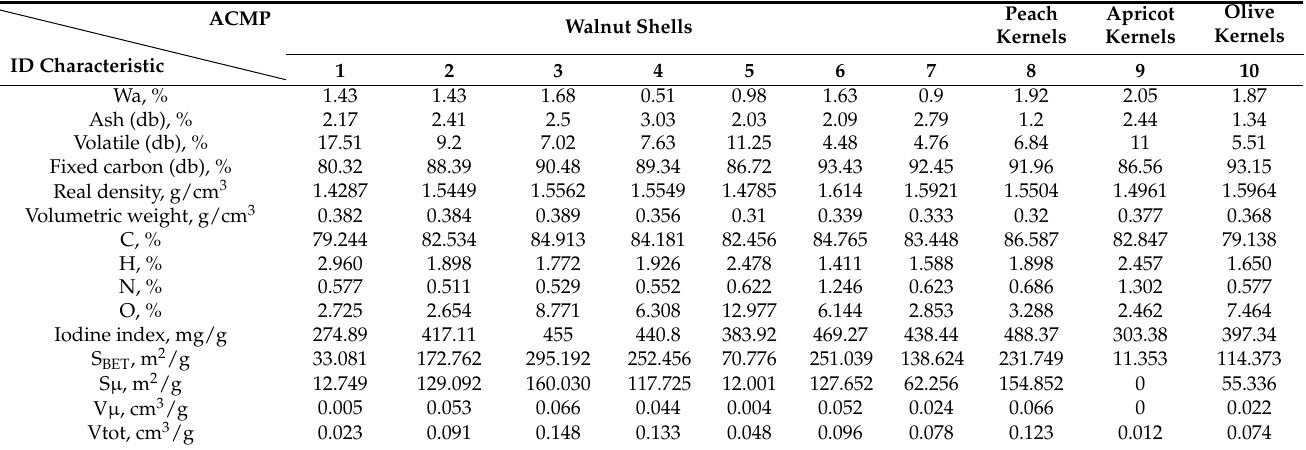
Table 2. Physical–chemical characteristics of the ACMP obtained in 3.3 kW equipment, with the porosimetric and textural parameters determined after processing the N 2 sorption